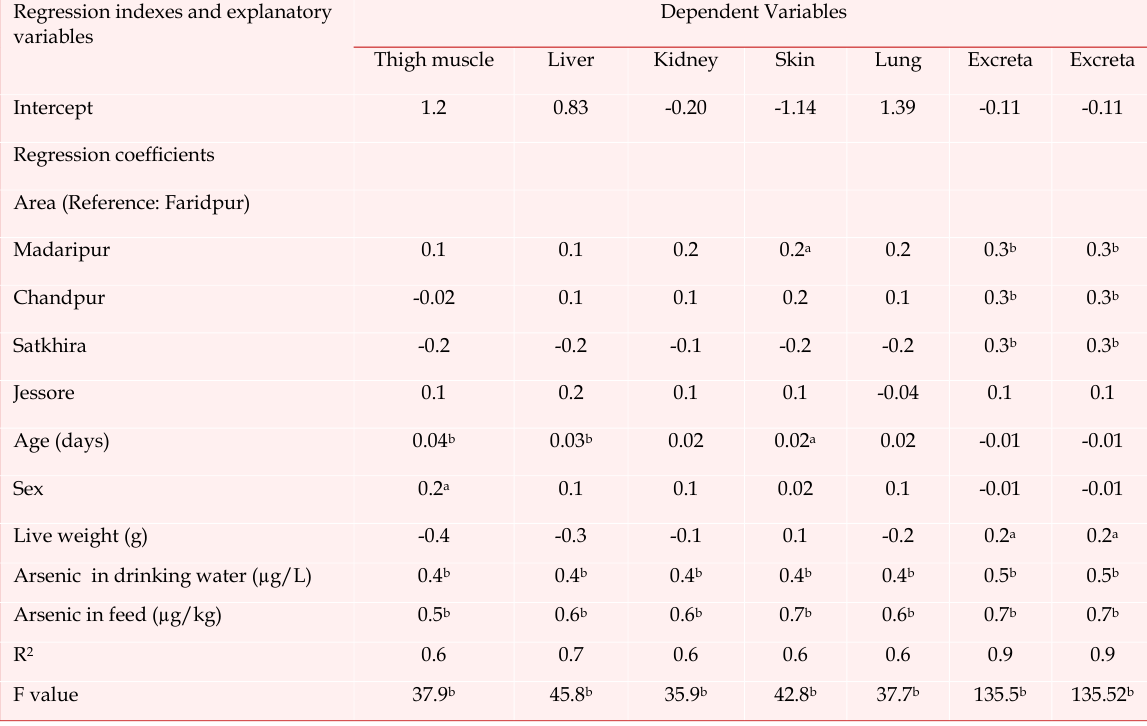
Multivariate multiple regression model for identifying the significant effects of the various arsenic exposure indexes on arsenic concentrations in tissues and excreta of broiler chickens